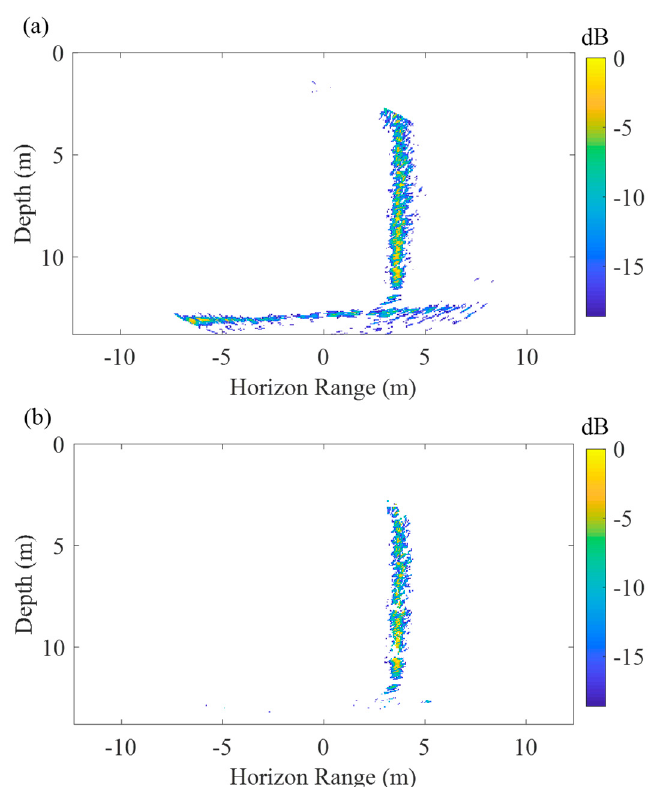
Figure 14. The result of the comprehensive detection of the data in Figure 12 using thresholds of pixel intensity, velocity magnitude, and velocity direction. ( a ) is the detection result using only the amplitude threshold, and ( b ) is the detection result of adding the magnitude of the velocity and direction